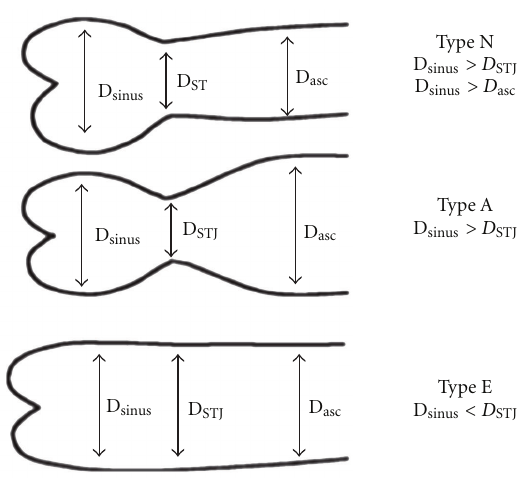
Figure 4: Three proximal aortic shapes in BAV disease [2].